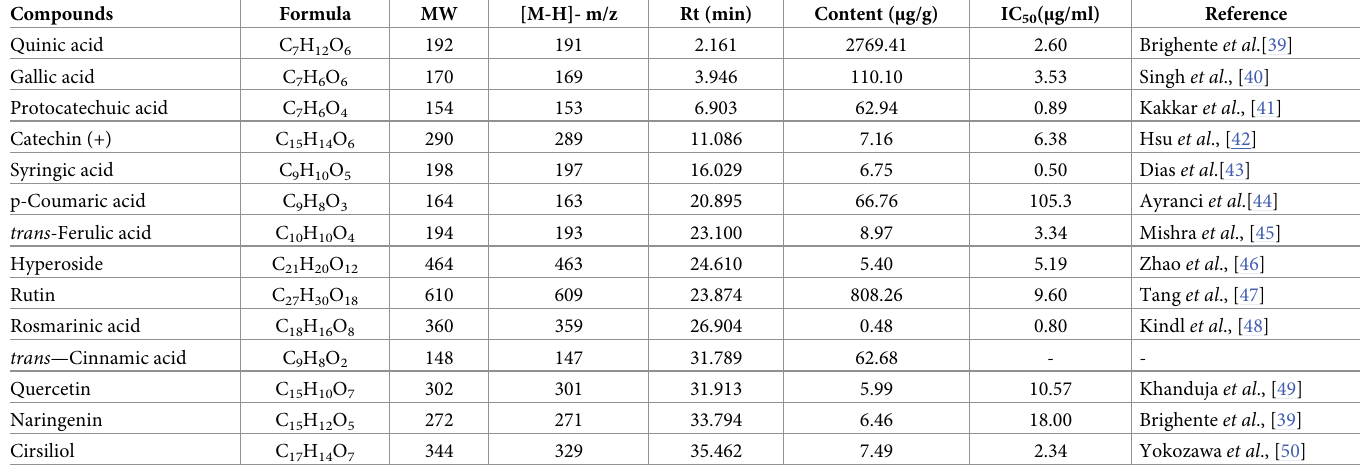
Table 2. LC-ESI-MS analysis of the Z . lotus fruit extract and literature review of the DPPH • radical-scavenging presented as extract concentration needed to scav- enge 50% of DPPH • (IC 50 )